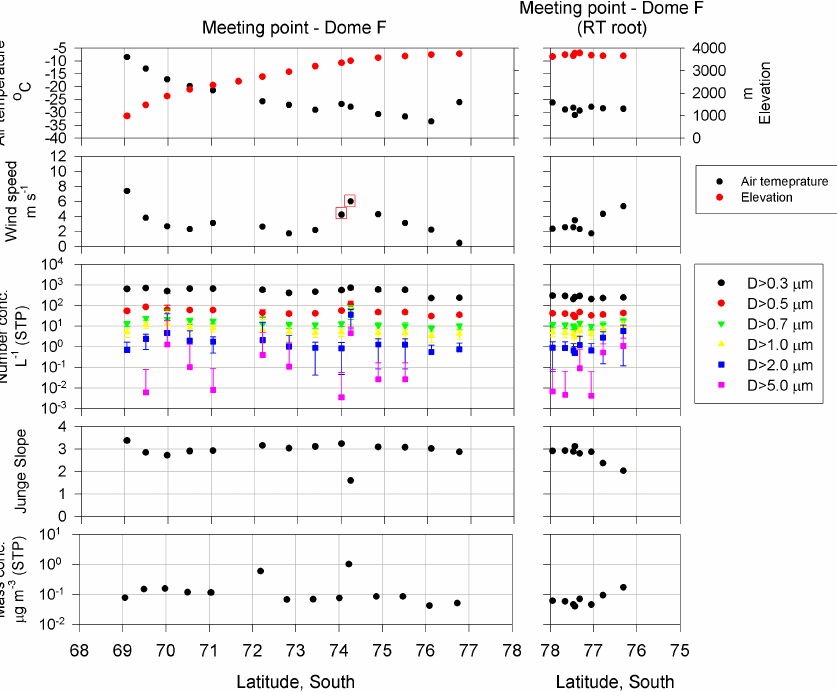
Figure 5. Horizontal features of air temperature, elevation, wind speed, aerosol number concentrations and Junge slope during outgoing traverse from the meeting point to S16. Red boxes show conditions with drifting